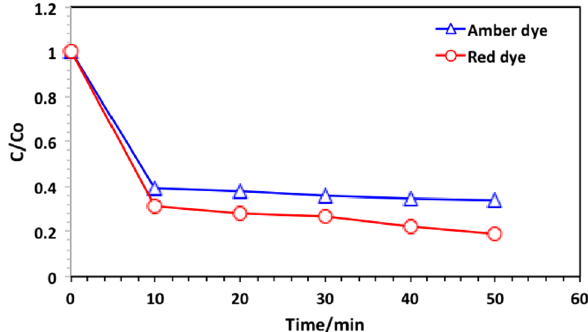
Fig. 10 Solar experiment of a LFR (Dyeo 100 mg/L; H2O2 800 mg/L; AS400 1 g/L; pH 3.0) and b LA (Dyeo 50 mg/L; H 2 O 2 200 mg/L; AS400 1 g/L; pH 3.0) azo-dyes removal during oxidation for different time ( t